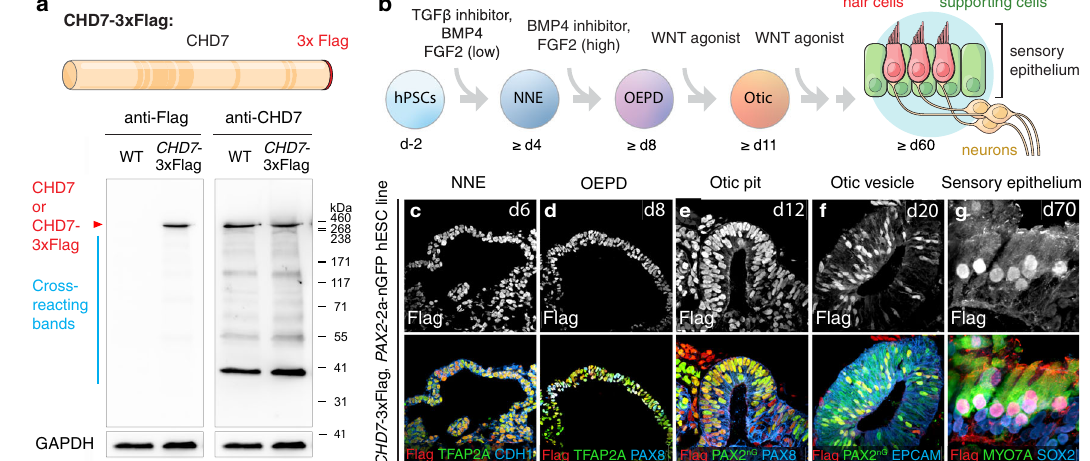
Fig. 1 | CHD7is expressed at keyoticdevelopment stages. a Westernblotting of WT ( PAX2 − 2a-nGFP cell line, hereafter PAX2 nG ) and CHD7 − 3×Flag hESCs using anti- Flag and anti-CHD7 antibodies. Calculated molecular weight of CHD7 and CHD7- 3×Flagare336kDaand339kDa,respectively.SourcedataareprovidedasaSource Data fi le. b Schematics of otic lineage differentiation during human inner ear organoid culture. Schematics adapted from Nie J, Hashino E. (2020) Generation of inner ear organoids from human pluripotent stem cells. Methods in Cell